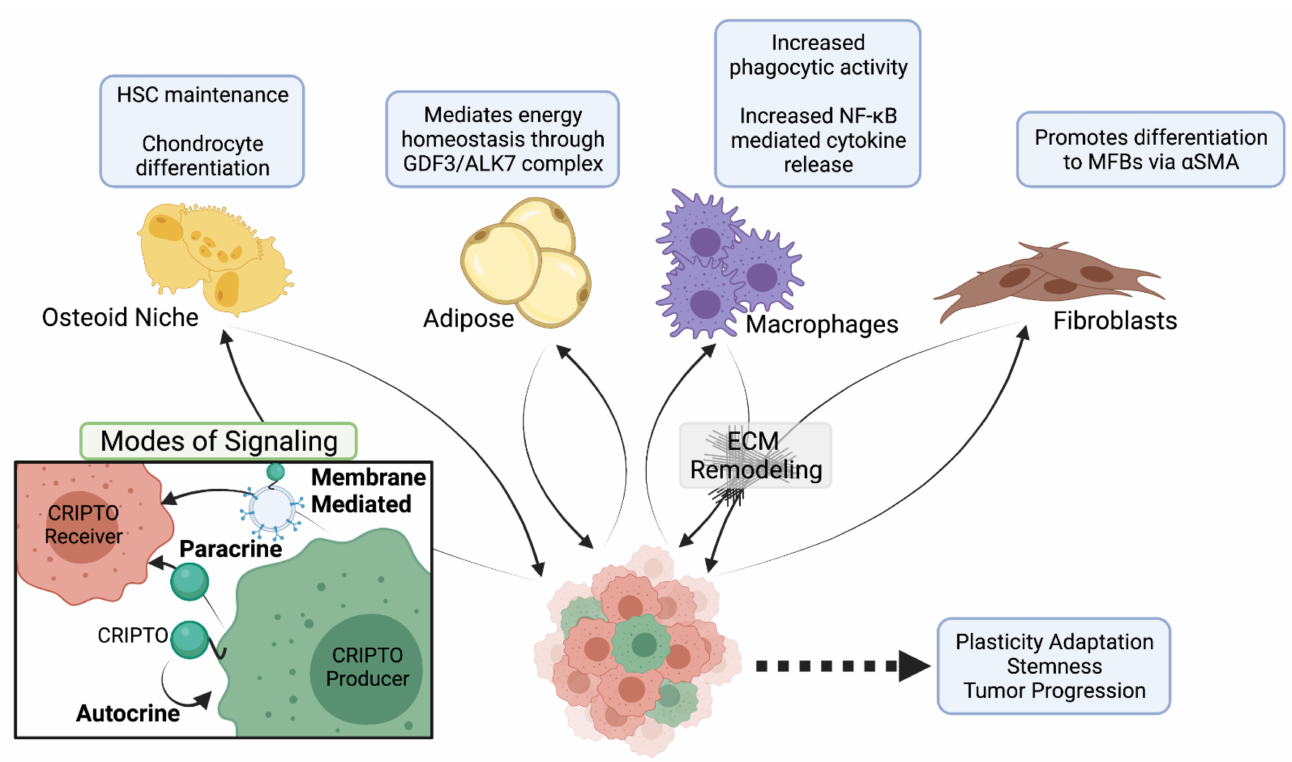
Figure 2. Effects of heterotypic CRIPTO signaling on various cell populations. Created in BioRender 15 August